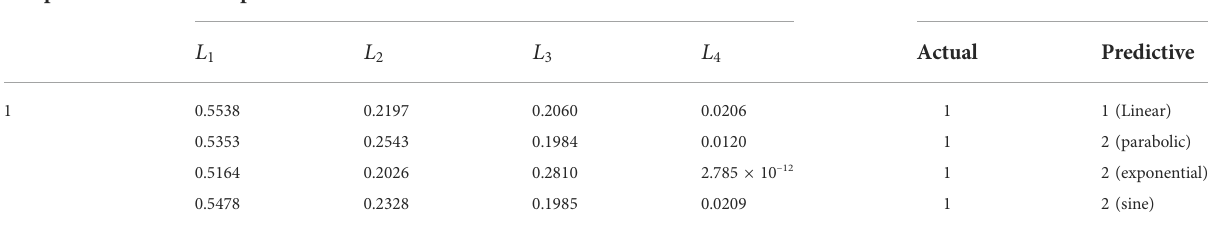
TABLE 5 Comprehensive unascertained measure based on linear function. Sample